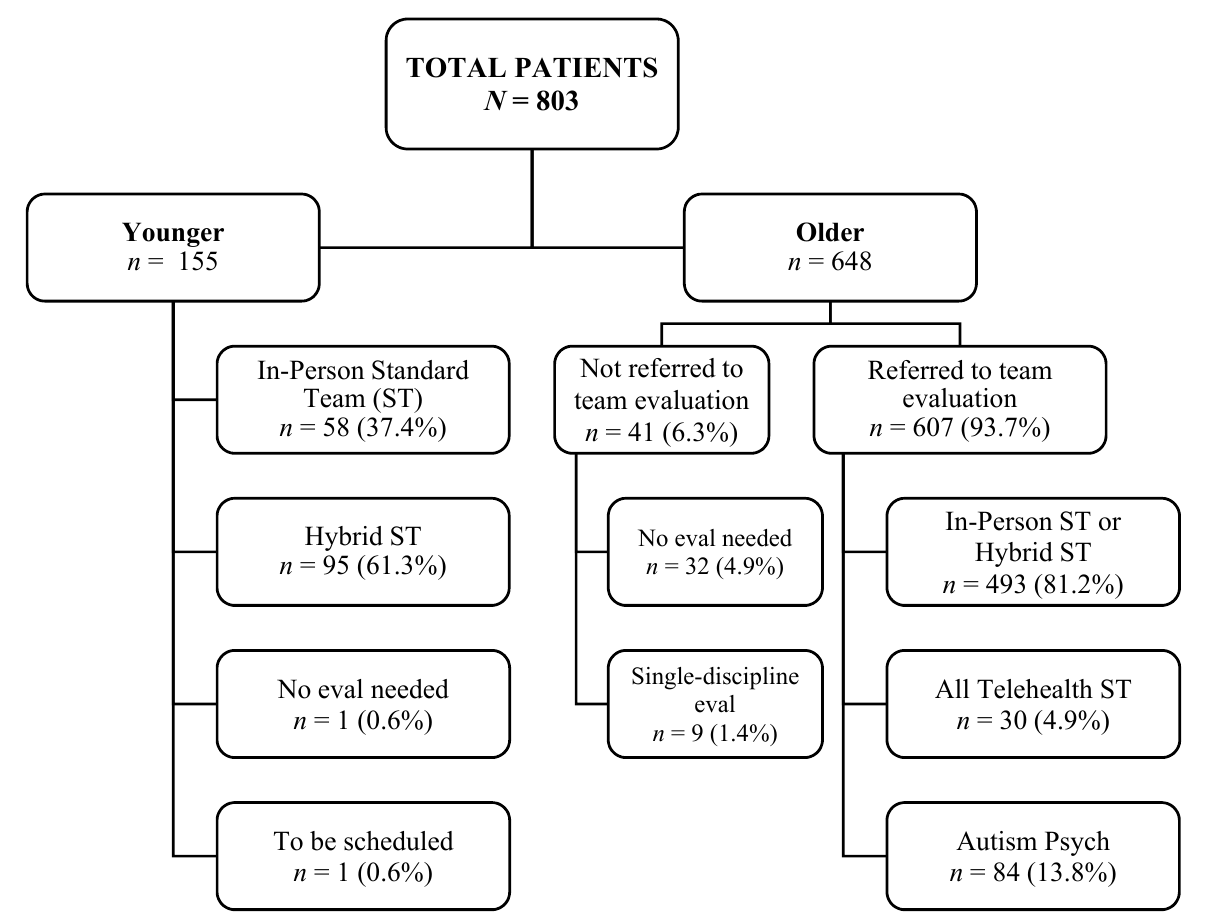
Figure 2. Evaluation referral tree, which summarizes how patients were triaged following diagnostic referral (Younger) and (Older) intake.